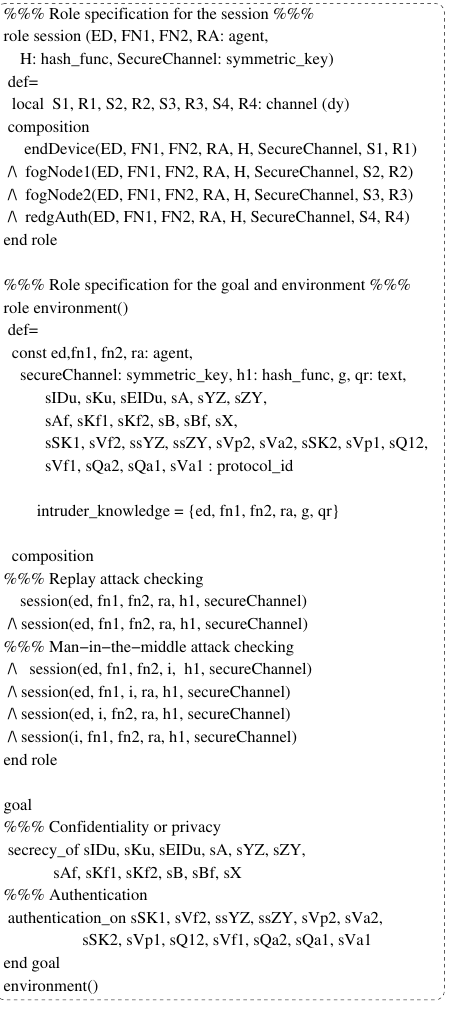
Figure 10. HLPSL role specification for the session, goal and